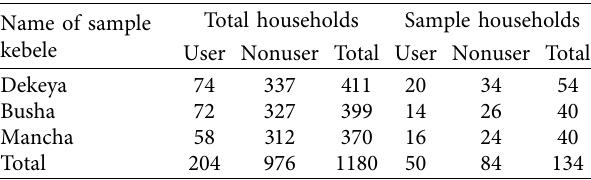
Table 1: Number of sample households from each kebele. Name of